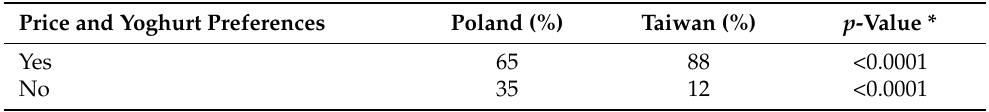
Table 5. Yoghurt preference depending on the price.